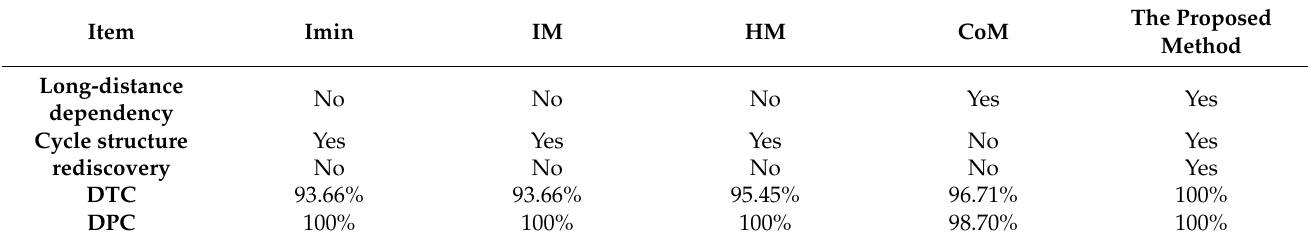
Table 11. Experimental results obtained by different